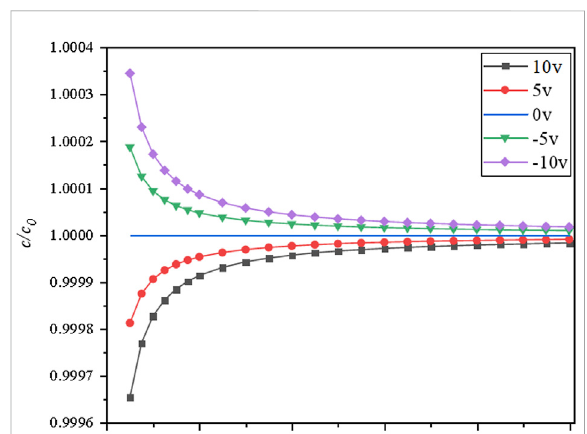
FIGURE 4 Dispersion curves for different piezoelectric